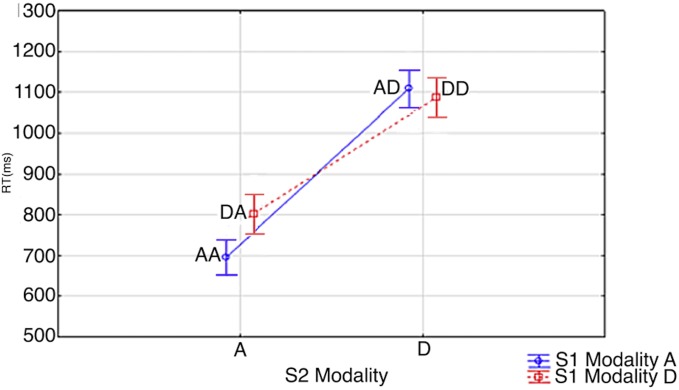
S1 Modality x S2 Modality.Vertical bars denote 0.95 confidence intervals for repeated measures ANOVA (Hollands & Jarmasz, 2009). S1 and S2 modality is signified by ‘A’ and ‘D’; ie. Arabic Digit (A) vs. Dot Matrix (D). As an example, AD signifies an Arabic digit at S1 and a dot matrix at S2.